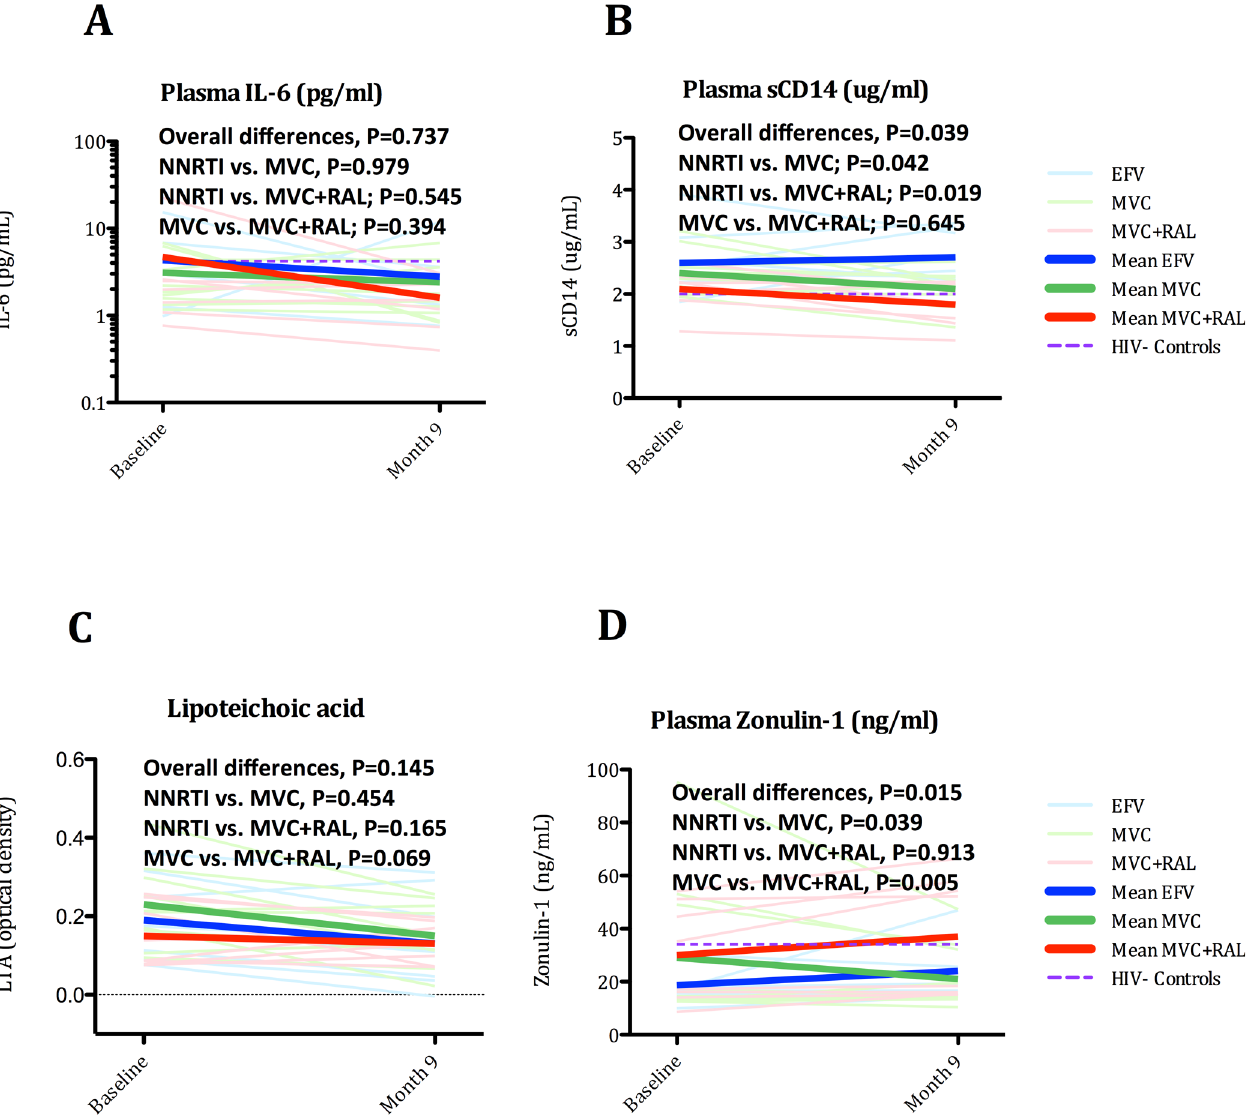
Fig 10. Effects of three ART regimens on markers of innate immunity. Panel A. Changes in plasma IL-6. Panel B. Changes in plasma sCD14. Panel C. Changes in plasma LTA. Panel D. Changes in plasma zonulin-1. The Purple dash line represents cross-sectional mean values in controls. The equality of all mean changes among the three groups was tested using a Wald test for the interaction term and is referred as “ Overall differences ” . A statistically significant interaction term (group * month) identified significantly different slopes between treatment